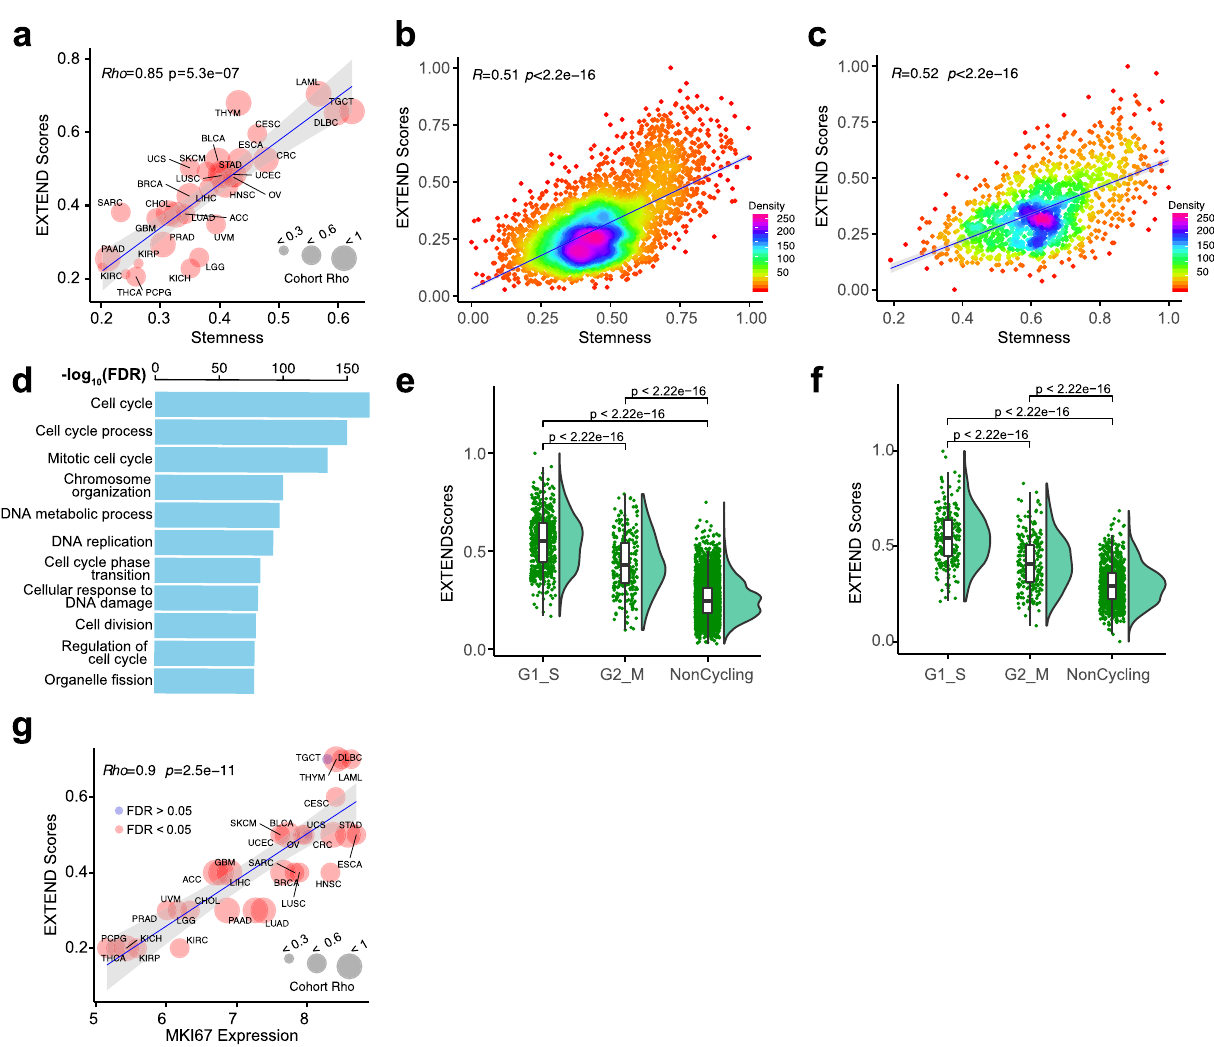
Fig. 4 Association between EXTEND score, cancer stemness, and proliferation. a Correlation between telomerase activity and cancer stemness across TCGA cohorts. Node size is proportional to correlation coef fi cients. In all cancer types, tumor stemness and telomerase activity is signi fi cantly correlated (FDR < 0.05). Shade indicates 95% CI of the regression. Spearman ’ s correlation was used to calculate Rho and P values for all plots unless otherwise stated. b , c Correlation between EXTEND score and cancer stemness at single-cell level in ( b ) glioblastoma and ( c ) head and neck cancer. Each dot represents one cell. d Top ten pathways enriched in the high stemness, high telomerase cells from head and neck cancer. P values are calculated using two- sided t test. Box indicates 25 – 75th quantile range. Middle bar indicates median. The minima and maxima are within 1.5 times the interquartile range of the lower and higher quartile. e , f EXTEND scores of cycling cells (G1 – S phase and G2 – M phase) and non-cycling cells in ( e ) glioblastoma and ( f ) head and neck cancer. g Correlation between EXTEND scores and proliferation marker MKI67 expression across 31 cancer types. This correlation is signi fi cant in all but two cancer types (FDR < 0.05 in blue). Shade indicates 95% CI of the regression similar to ( a